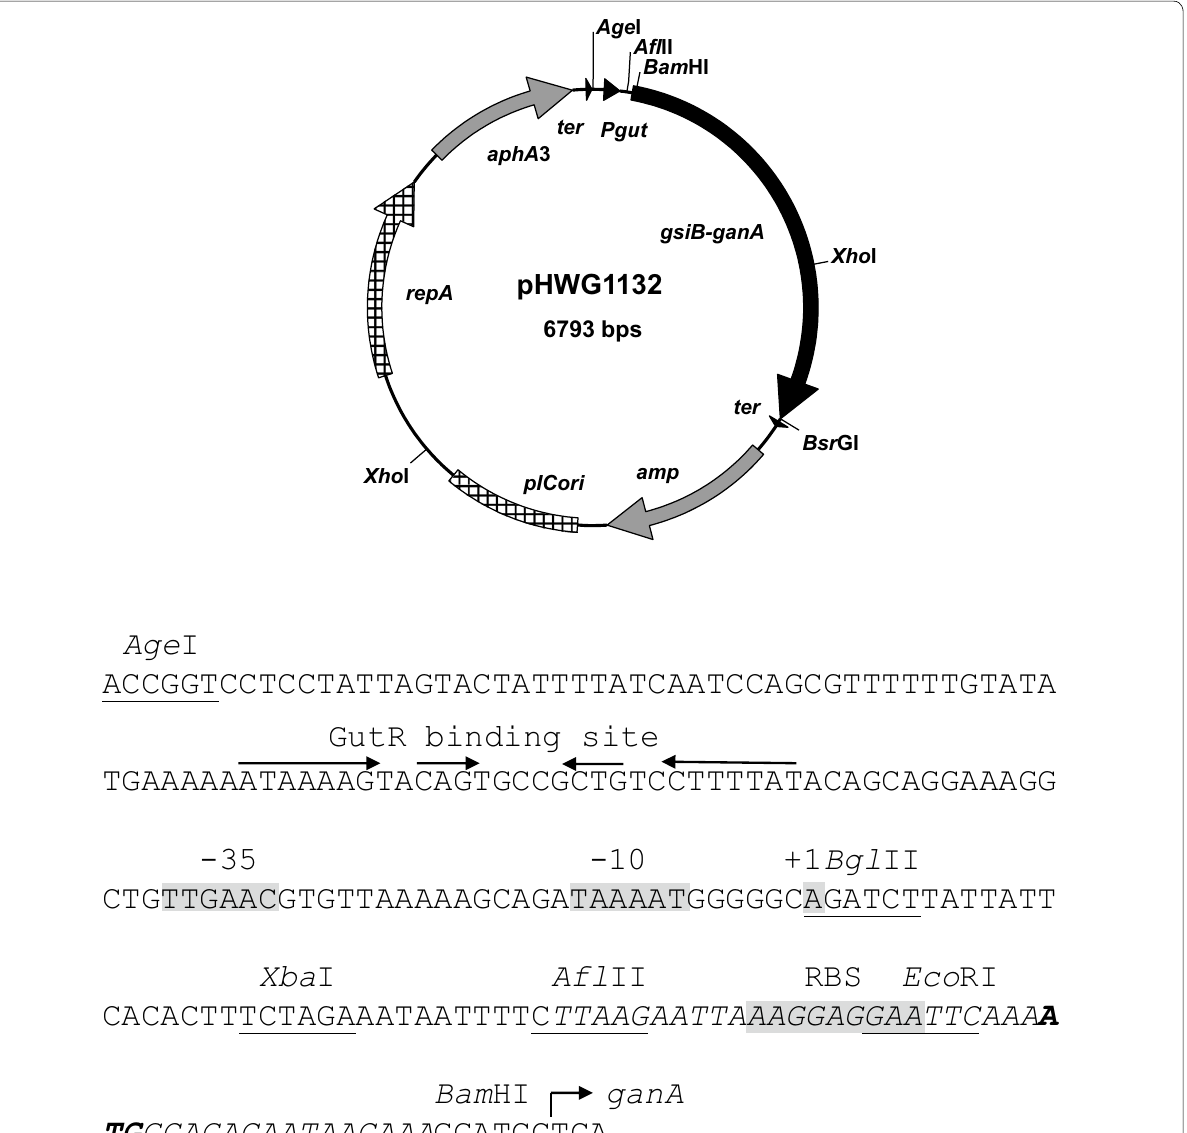
Fig. 1 Restriction map of the expression vector pHWG1132 and the transcription and translation initiation region of ganA consisting of the gut promoter with the GutR binding site (arrows) and the the ATG start codon in bold letters and restriction sites are underlined. The sequence between the Bgl II site and Afl II site is derived from vector